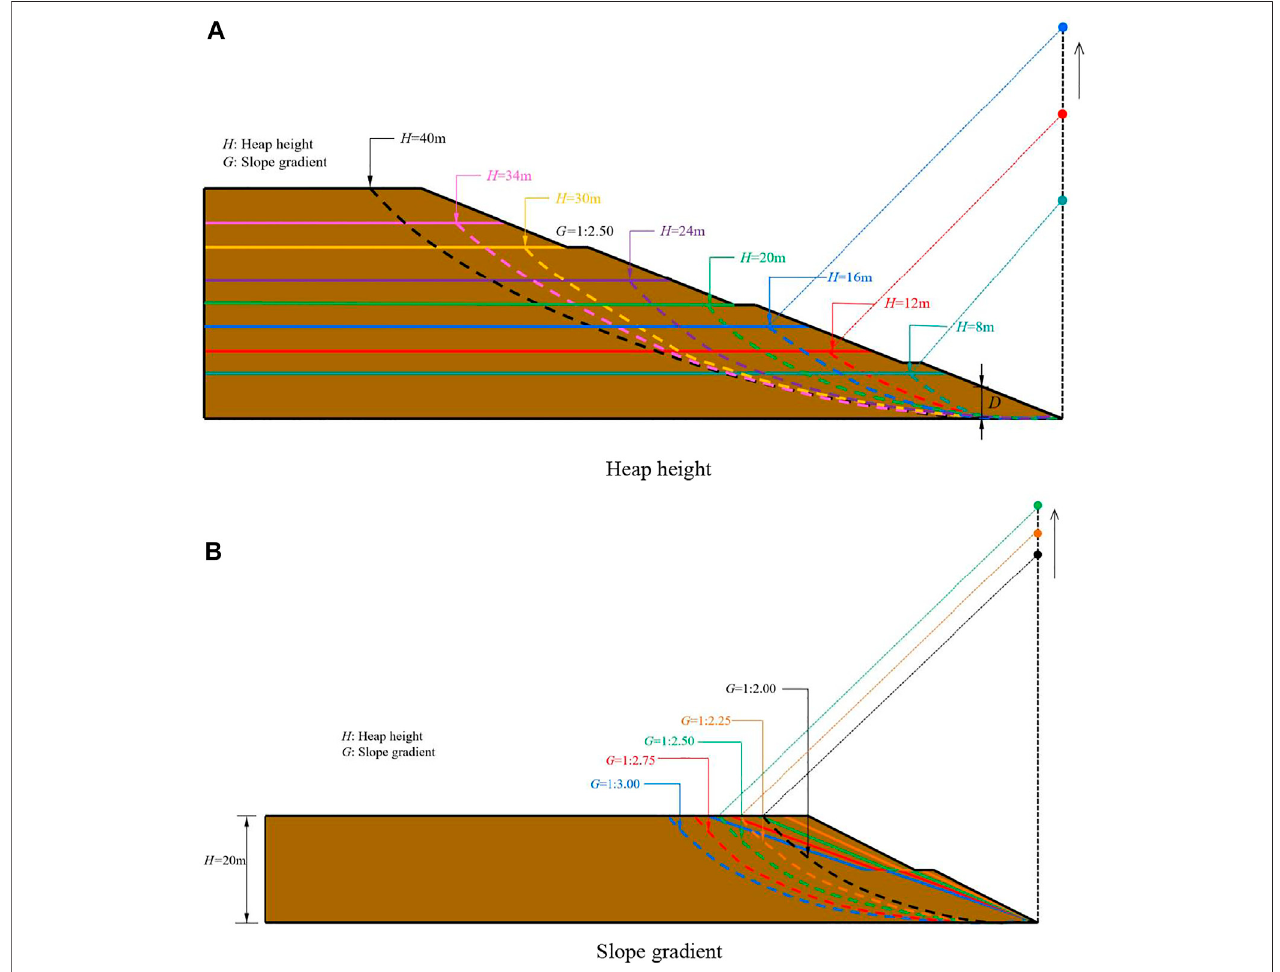
FIGURE 4 | Effect of design parameters on the location of potential slide surface. (A) Heap height, (B) slope gradient.